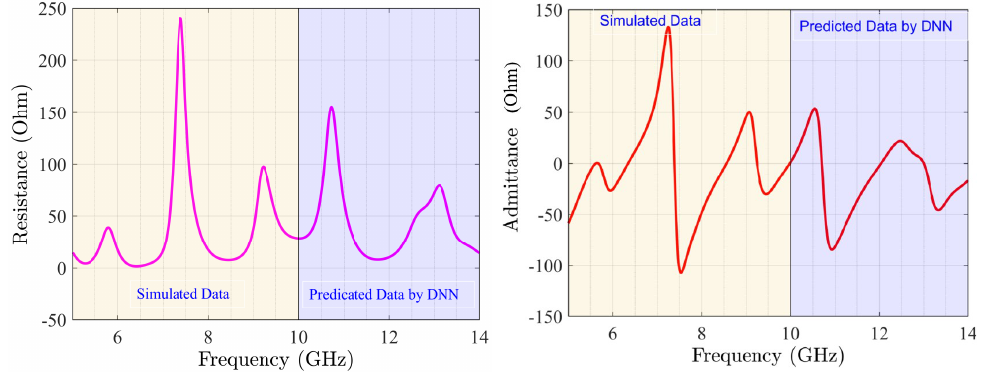
Figure 8. S 12 of optimized MIMO.